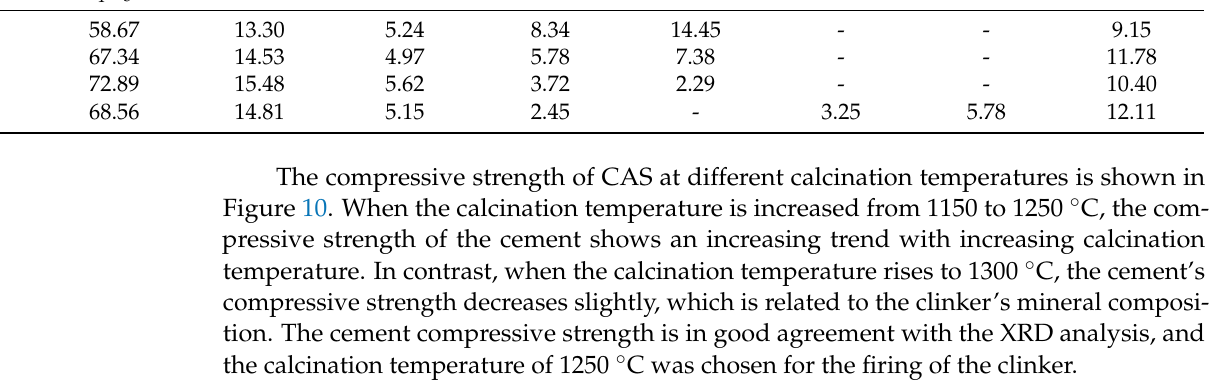
Table 6. Contents of S2 samples fired at different temperatures (wt.%).